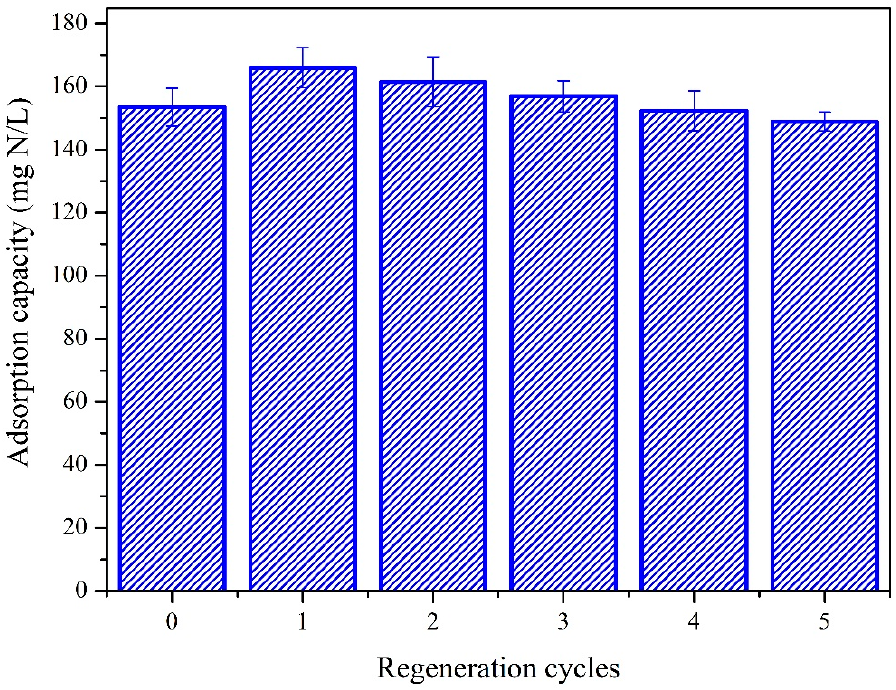
Figure 7. The adsorption capacities with regeneration times.